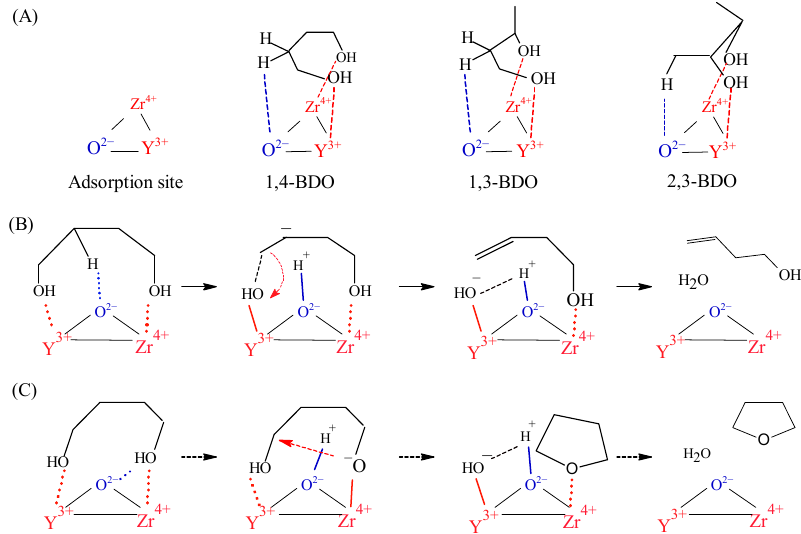
Figure 11. Possible coordination structures with adsorption site ( A ) and reaction mechanism for the dehydration of 1,4-BDO to form 3B1ol ( B ) and THF ( C